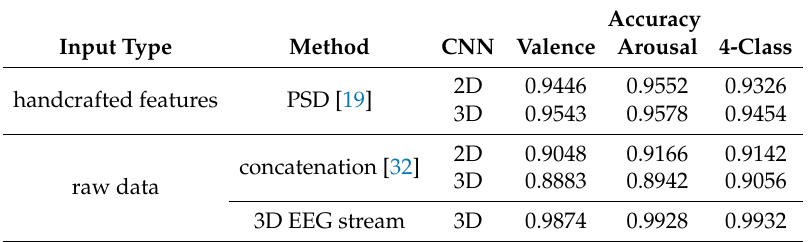
Table 4. Average accuracies of bianry and 4-class classification using different approaches with several input types on the DEAP